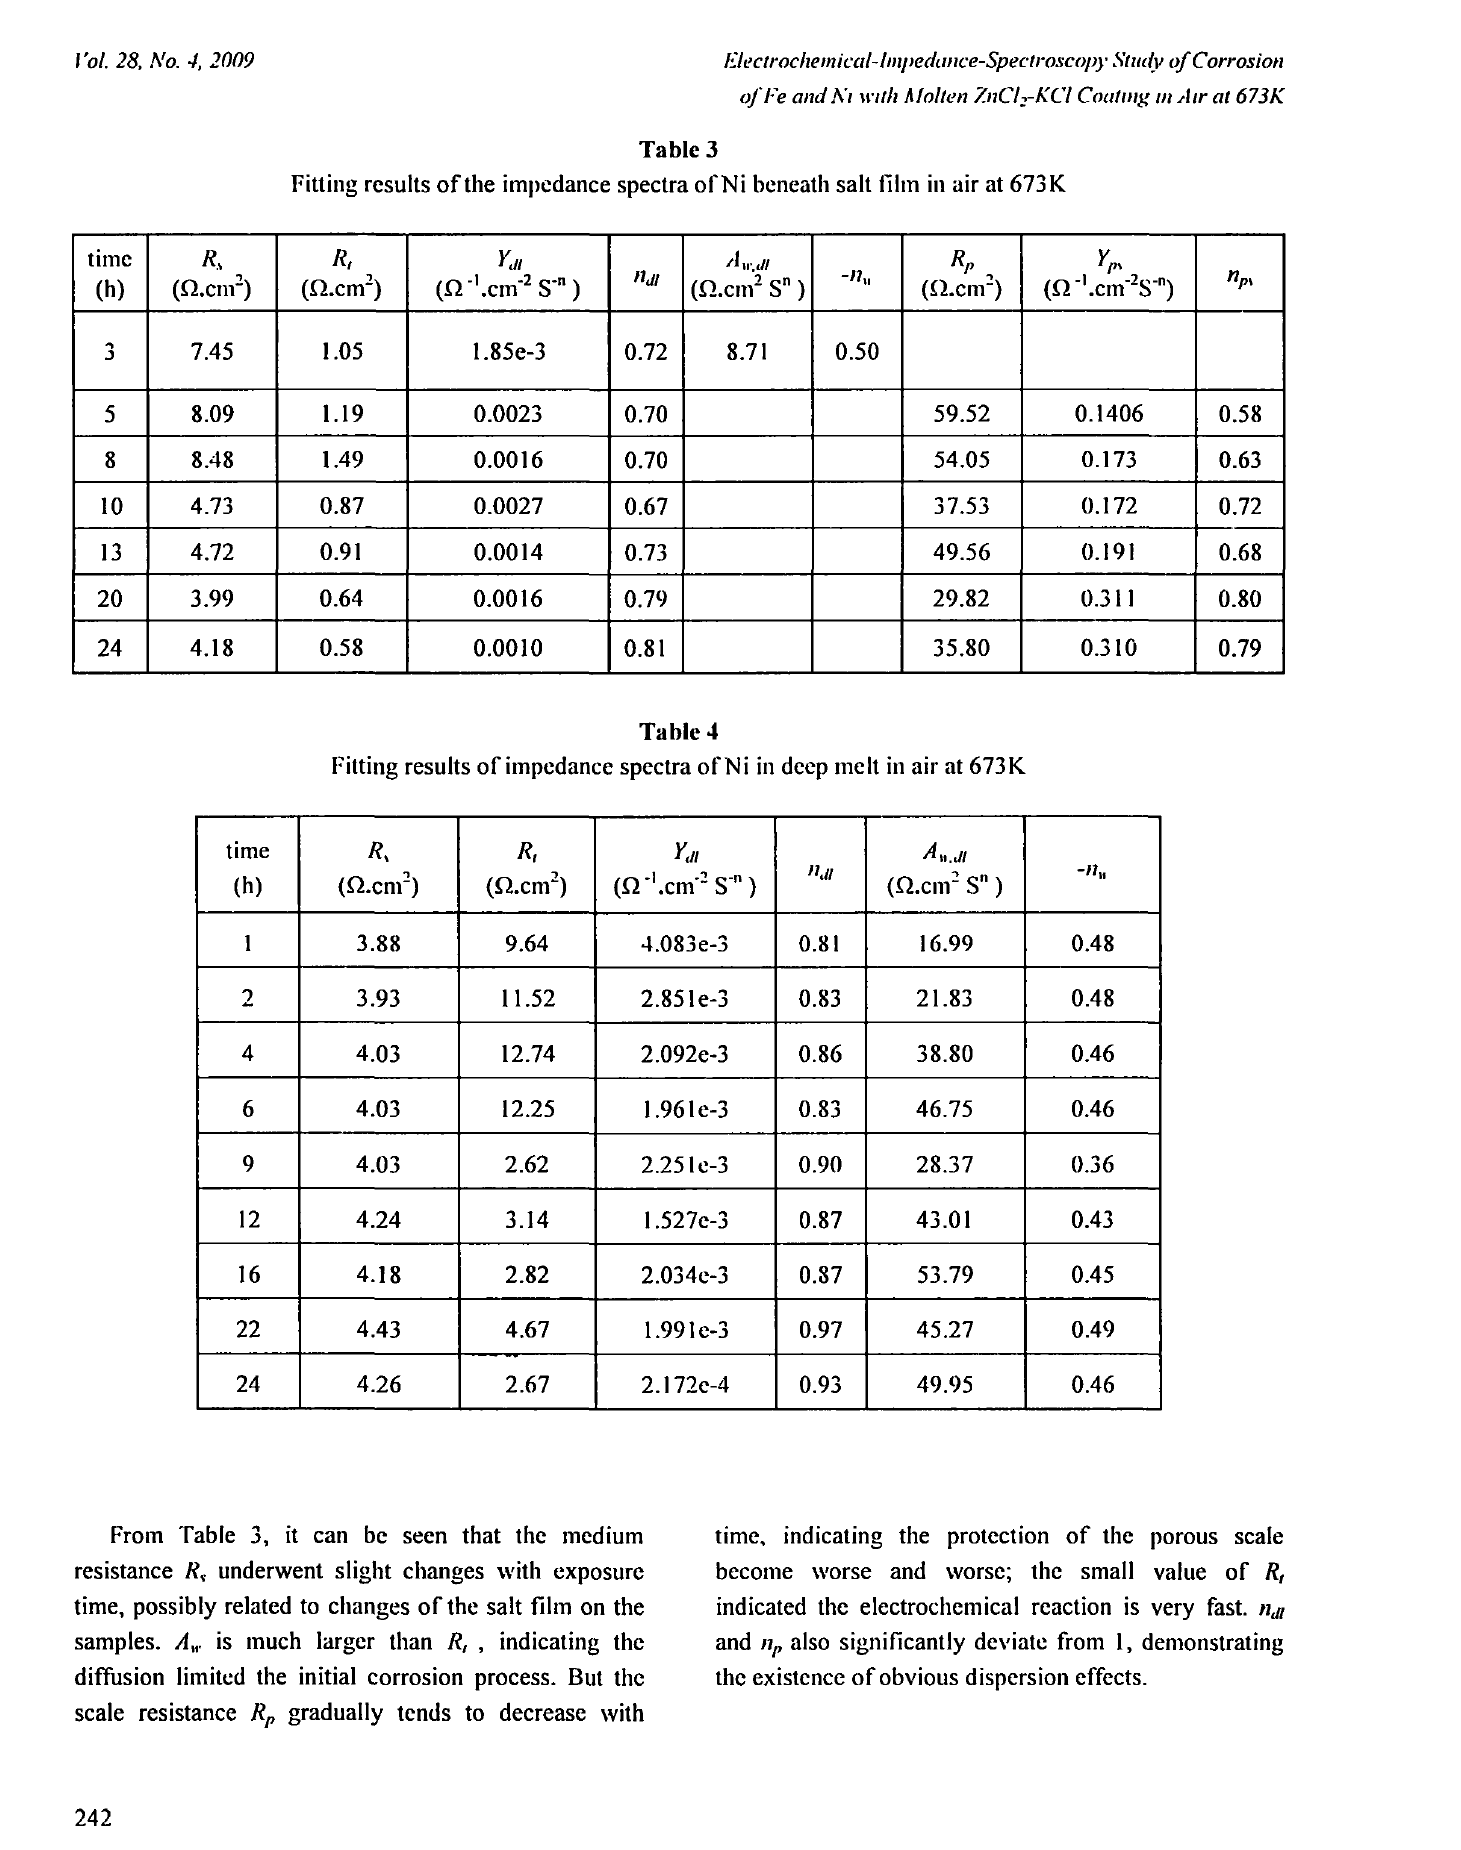
Fitting results of the impedance spectra of Ni beneath salt film in air at 673 K